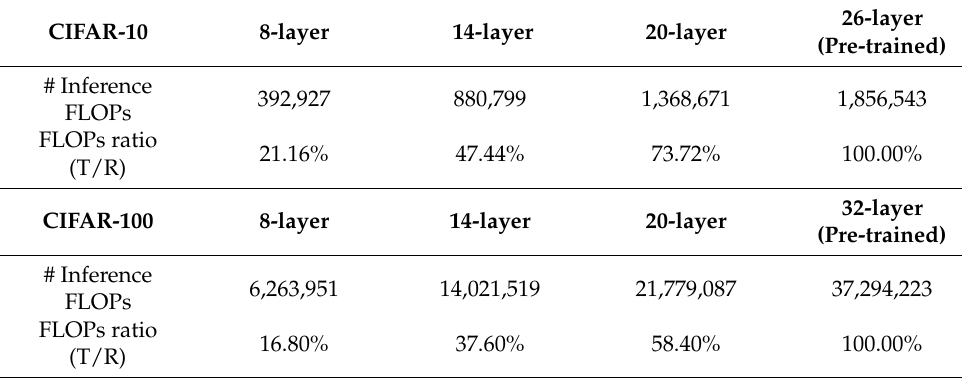
Table 8. Comparison results of total number of FLOPs for inference in the proposed method on CIFAR-10 and CIFAR-100 between the target networks and the pre-trained